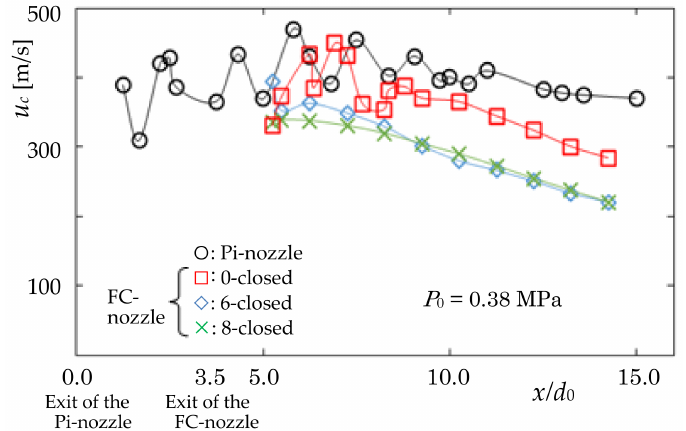
Figure 5. Jet centerline velocity distribution, u c (0-, 6-, 8-closed jets and Pi-jet, P 0 = 0.380 MPa): The u c of the 0-closed nozzle is smaller than that of the Pi-jet owing to the large flow resistance of the